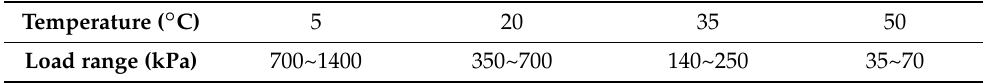
Table 4. Load levels at different temperatures.